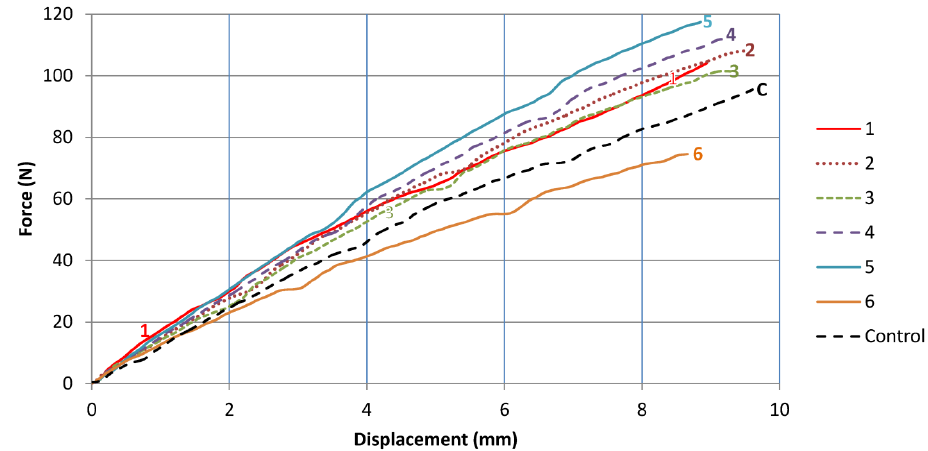
Figure 8. Force vs . deflection tool displacement for squeegees.